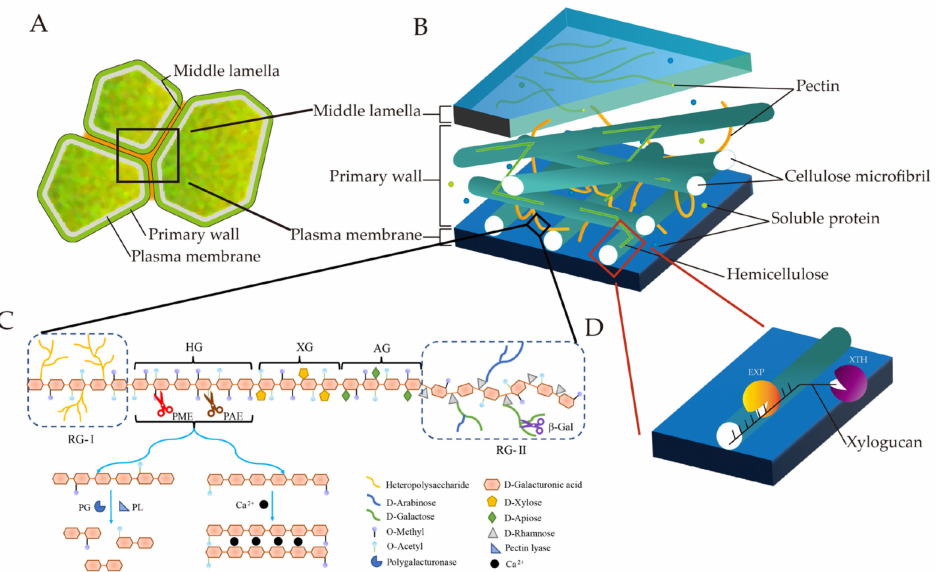
Figure 1. Cell wall structure. ( A ) Schematic representation of the cell wall structure of three cells; ( B ) schematic representation of the structural components of the cell wall (after Farinati et al. [75]); ( C ) schematic representation of the pectin structure. Pectin is composed of five different types of polysaccharides, and various pectin-degrading enzymes are involved in pectin degradation (see text); ( D ) The cross-linking structure of hemicellulose and cellulose microfibril, EXP and XTH are involved in the depolymerization of the